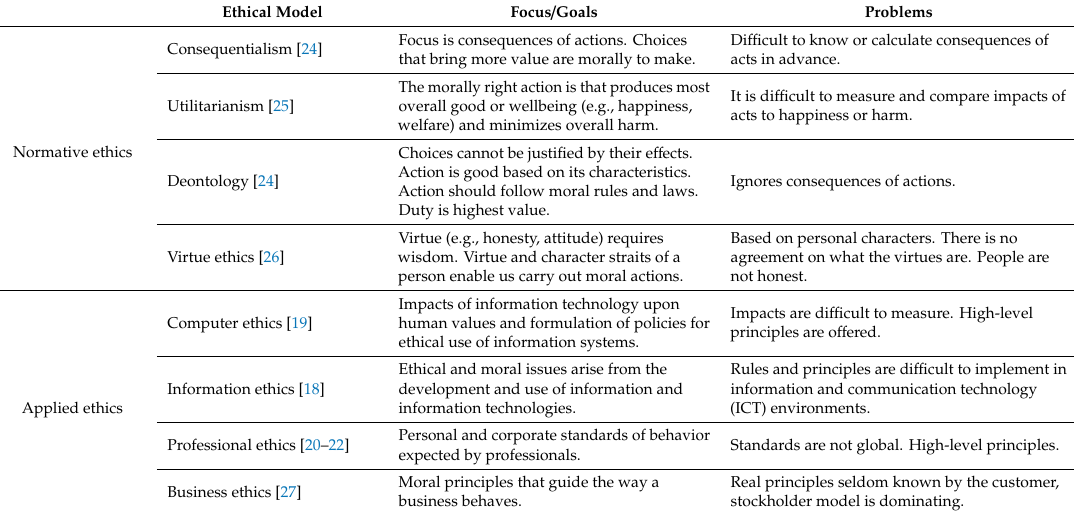
Table 1. Widely used ethical models and their